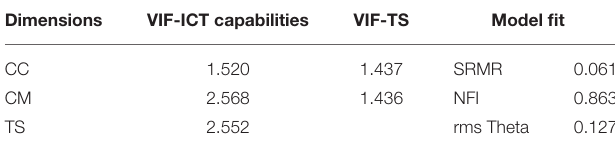
TABLE 2 | Reliability and convergent validity.